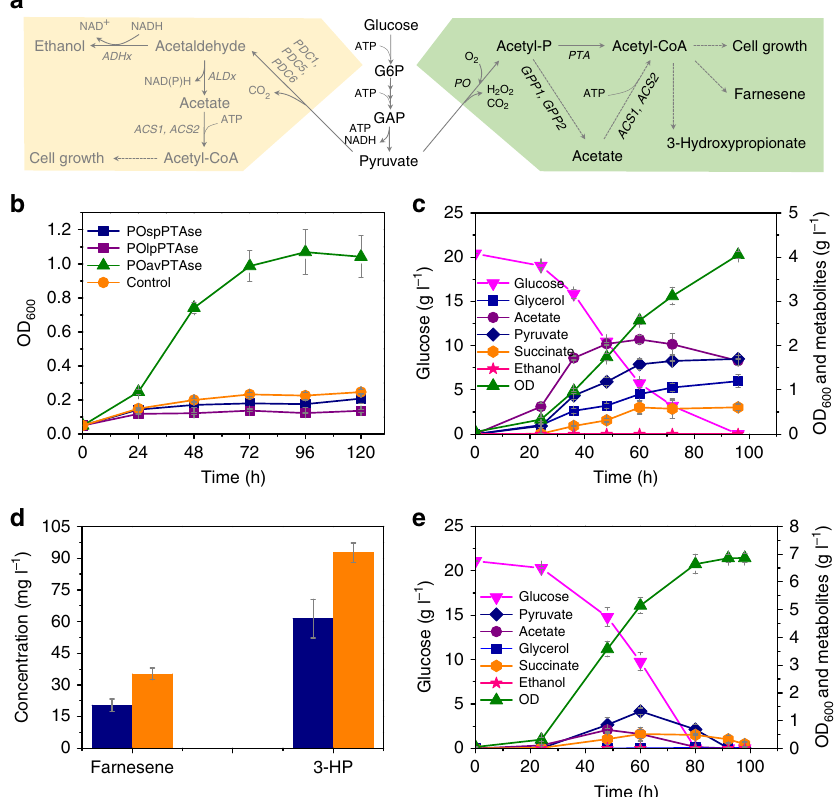
Fig. 1 Establishment of a cytosolic acetyl-CoA synthetic pathway in Pdc − S. cerevisiae . a The native and alternative cytosolic acetyl-CoA synthetic pathway in S. cerevisiae . The native metabolic network (yellow background) converts pyruvate to acetyl-CoA by pyruvate decarboxylase (Pdc1, 5, and 6), acetaldehyde dehydrogenase (Ald2, 3, 4, 5, and 6), and acetyl-CoA synthetase (Acs1 and 2). The metabolic network (green background) converts pyruvate to acetyl-CoA by pyruvate oxidase (PO) and phosphotransacetylase (PTA). b Growth curve of a Pdc − yeast strain carrying different PO/PTA plasmids in a synthetic medium containing 20 g l − 1 glucose. sp: S. pneumoniae , lp: L. plantarum , av: A. viridans , se: S. enterica . c Growth and metabolite pro fi les of sZJD-11 ( acs2 Δ :: POav acs1 Δ :: PTAse ) in 20 g l − 1 glucose minimal medium. d Acetyl-CoA-derived farnesene and 3-hydroxypropanoate (3-HP) production in wild-type strain CEN.PK113-11C (orange bar) and sZJD-11 (blue bar) background strains. e Growth and metabolite pro fi les of sZJD-23 ( acs2 Δ :: POav acs1 Δ :: PTAse gpp1 Δ gpp2 Δ ) in 20 g l − 1 glucose minimal medium. All data represent the mean ± s.d. of biological